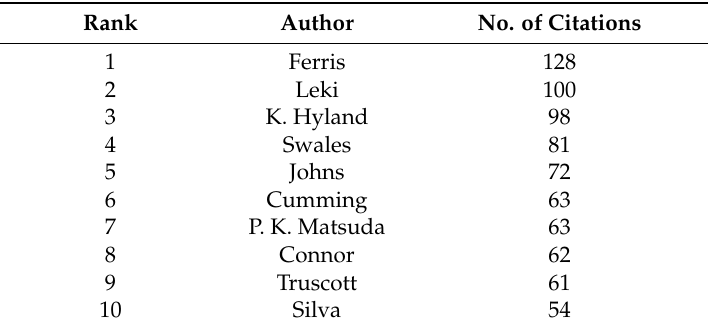
Table 9. The top ten authors frequently cited in SLW